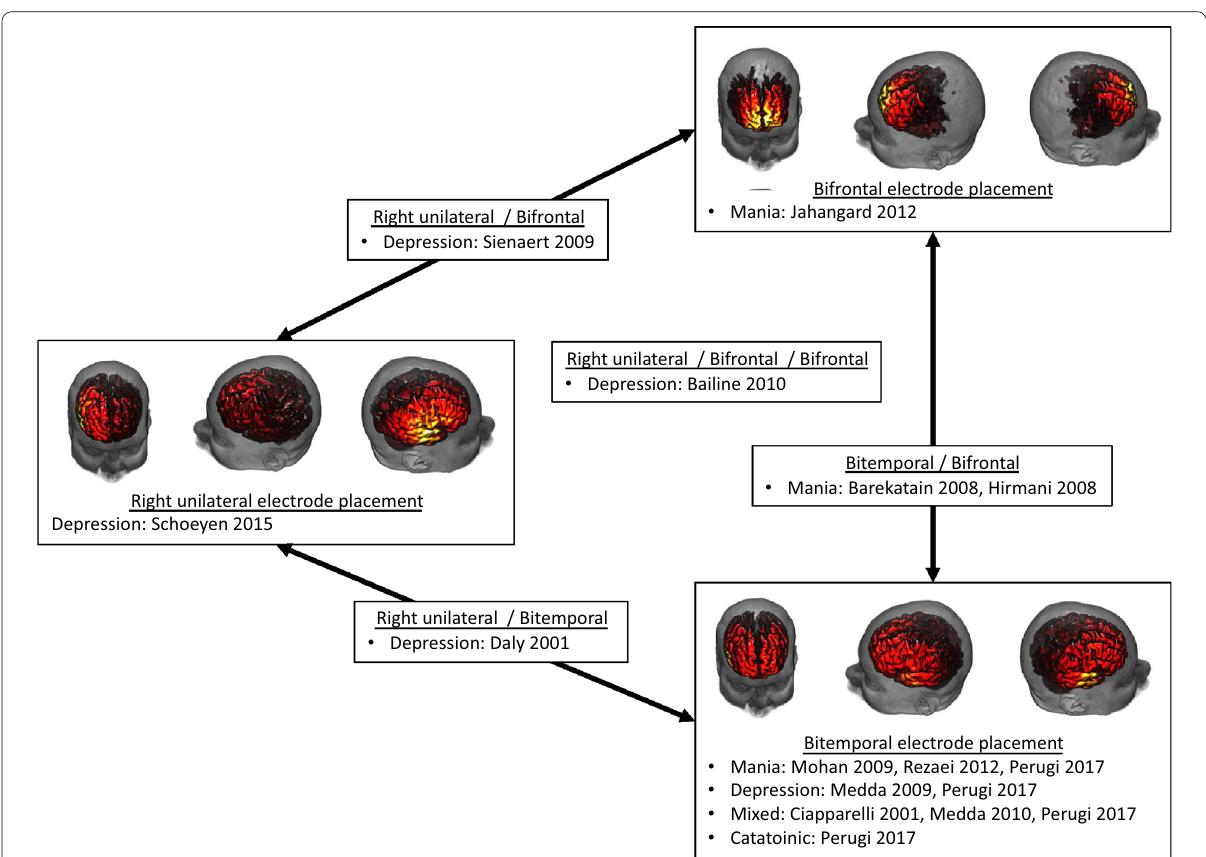
Fig. 1 Electric field modeling for bitemporal, right unilateral and bifrontal electrode placements with the associated studies included in this review. The electric field is modeled for 800 milliamperes with a threshold of 0.35 V/cm (threshold for neuronal